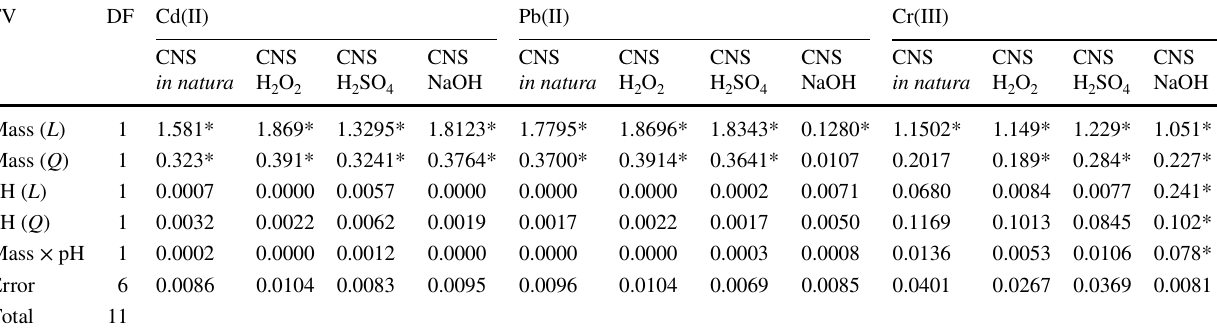
Table 5 Analysis of variance (ANOVA) for cashew nut shell (CNS) in natura , CB H Cd 2+ , Pb 2+ and Cr 3+